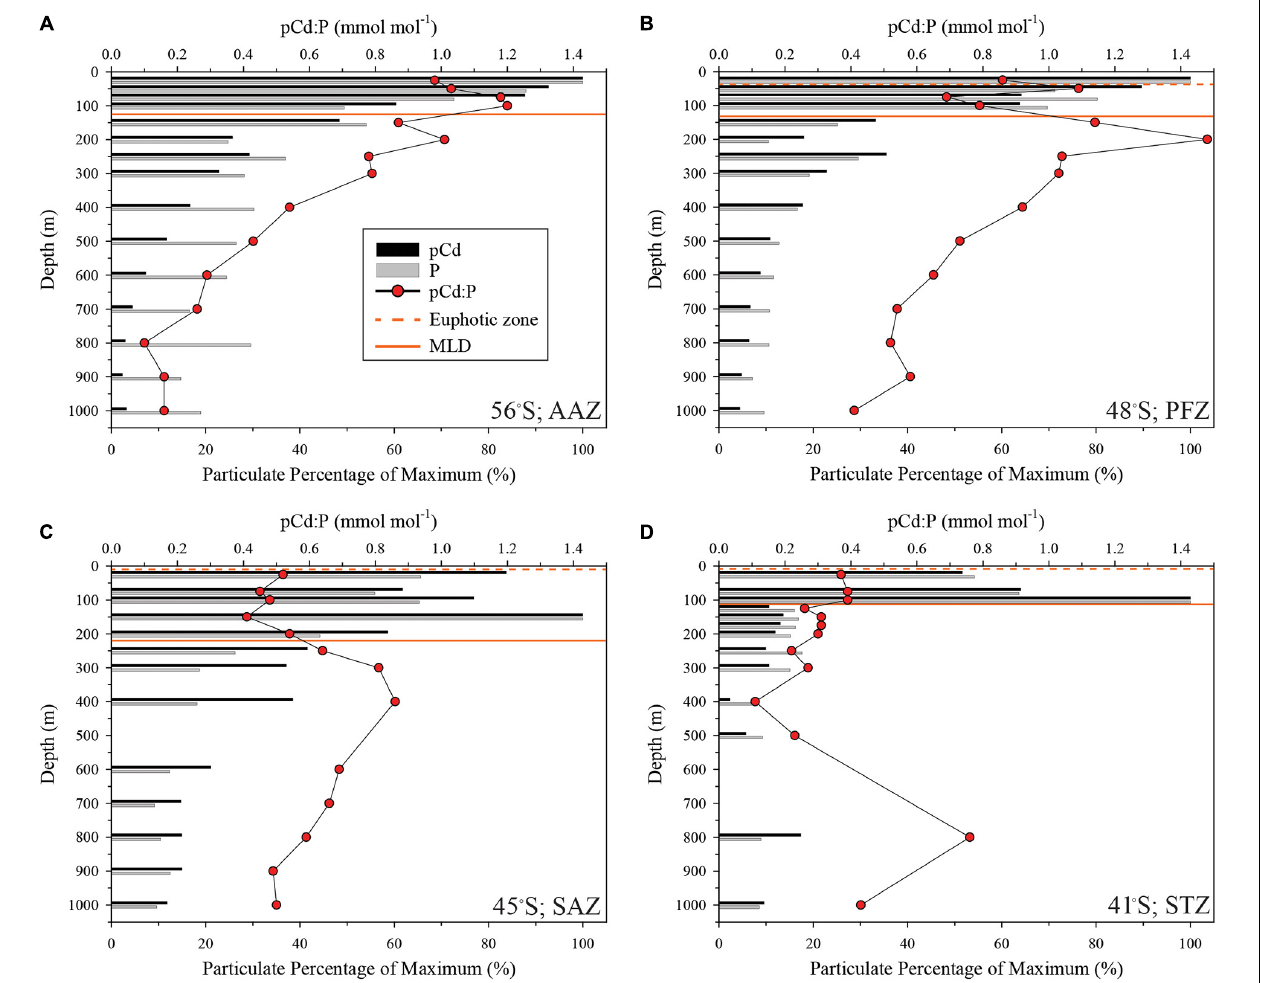
FIGURE 6 | Particulate cadmium (black bars) and P (gray bars) normalized to profile maximum values (bottom axis) for the upper 1,000 m in (A) the AAZ, (B) the PFZ, (C) the SAZ, and (D) the STZ. The red dots are the absolute pCd:P ratios at each depth (top axis). Dashed horizontal lines represents the bottom of the euphotic zone at each station. Solid horizontal line represents the bottom of the MLD at each station. No euphotic zone data for 56 ◦ S (AAZ) due to PAR sensor